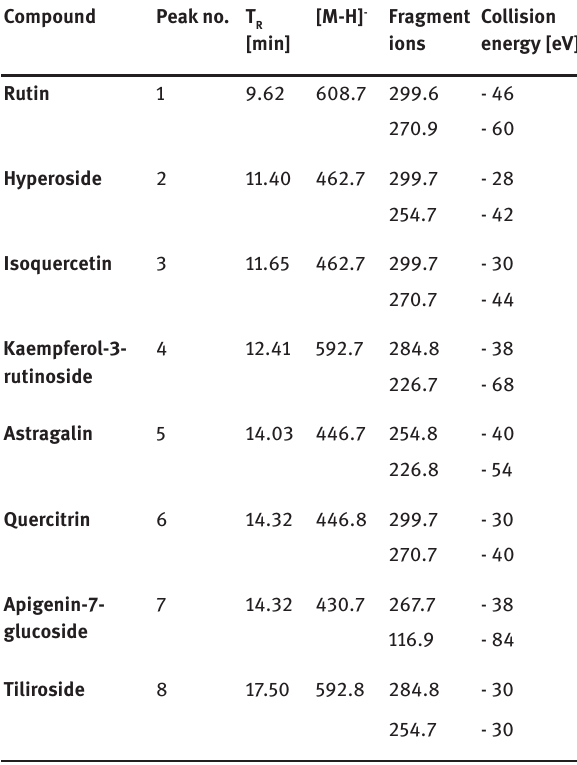
Table 1: LC-ESI-MS/MS phenolic acids results. Compound